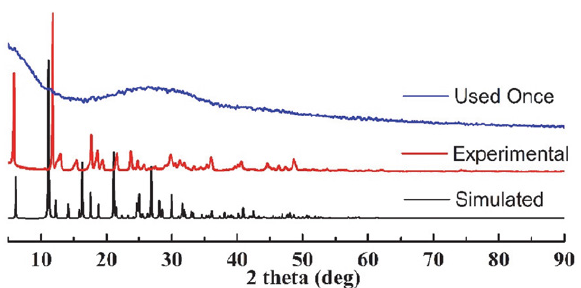
Figure 3. XRD pattern of the simulated and experimental calcium 4-amino-3-hydroxybenzoate and the catalyst used